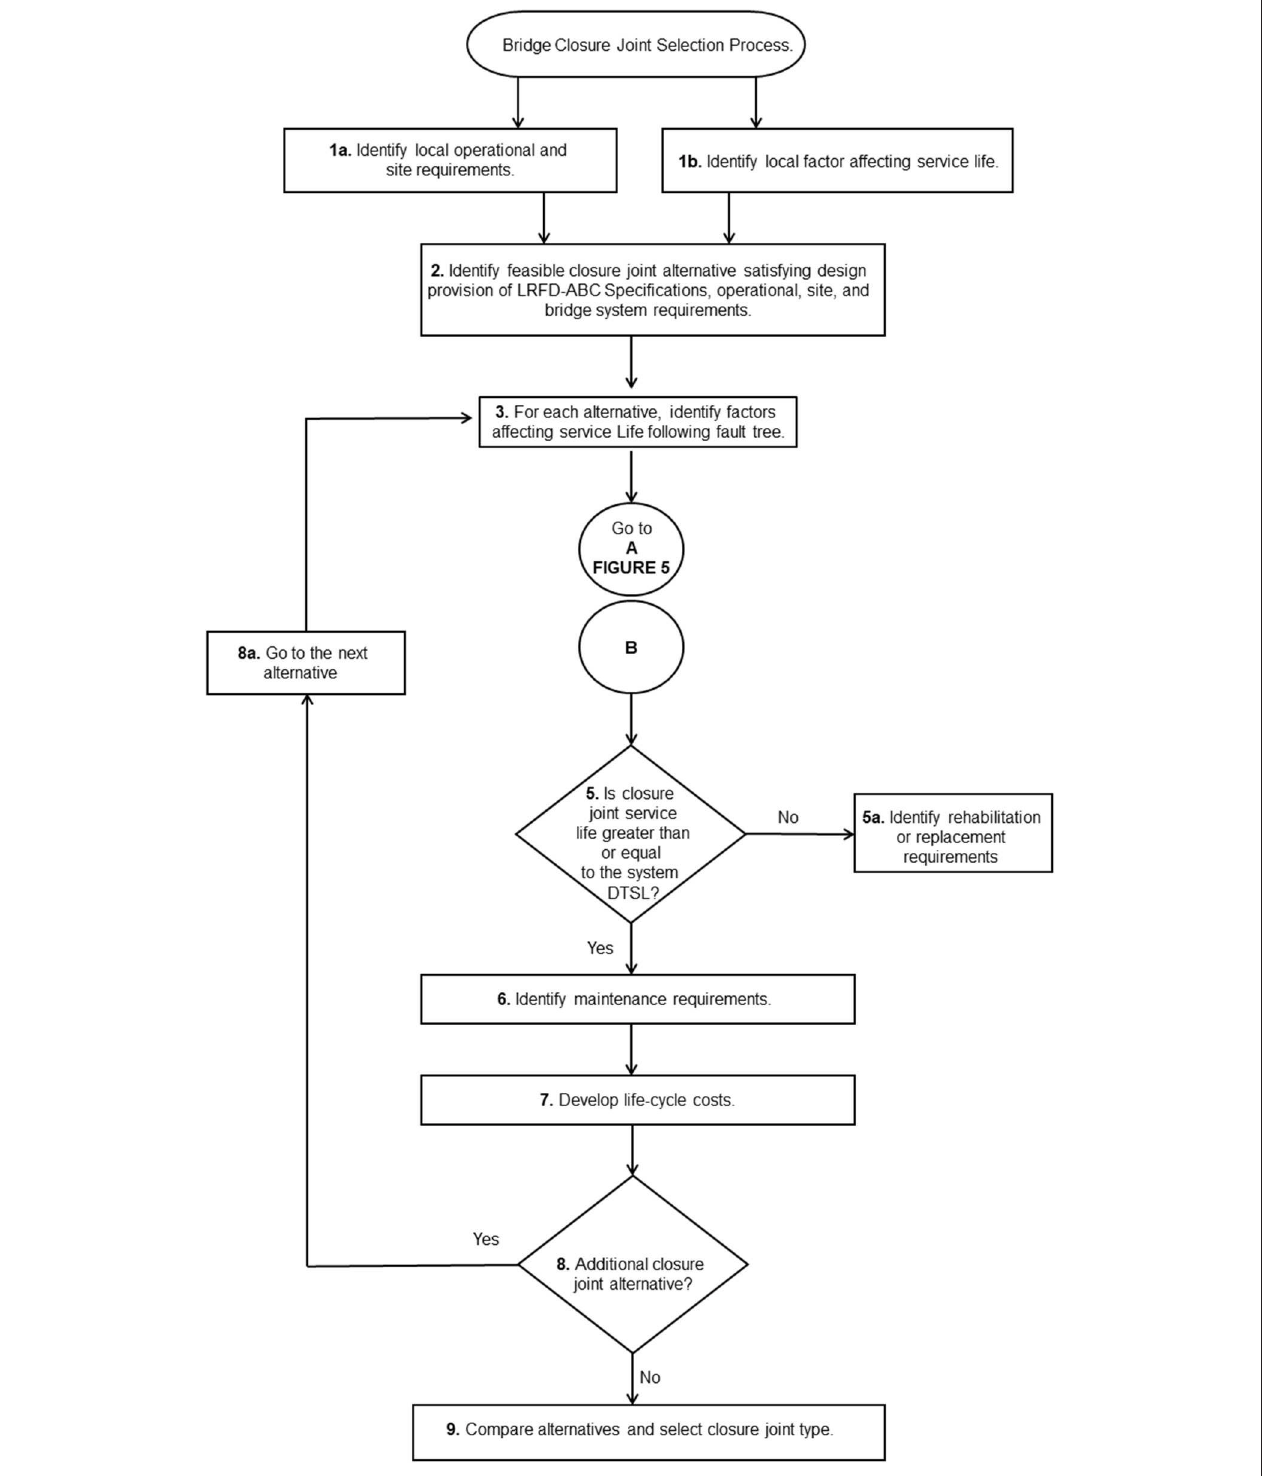
FIGURE 4 | Bridge closure joint selection